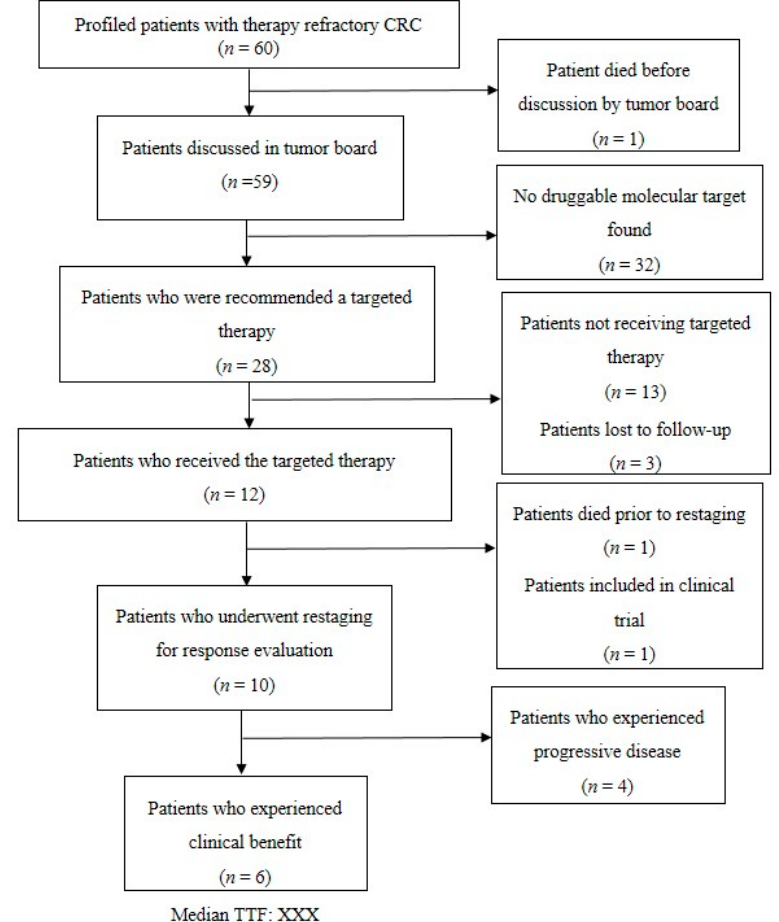
Figure 1. Flow chart of the 60 metastatic colorectal cancer (mCRC) patients.